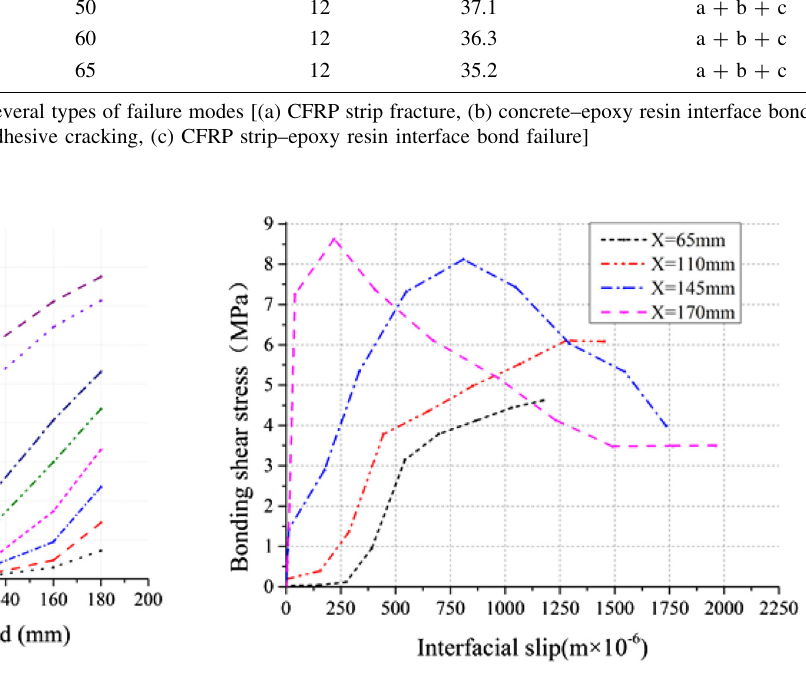
Fig. 10 Bond–slip at different positions (T60)